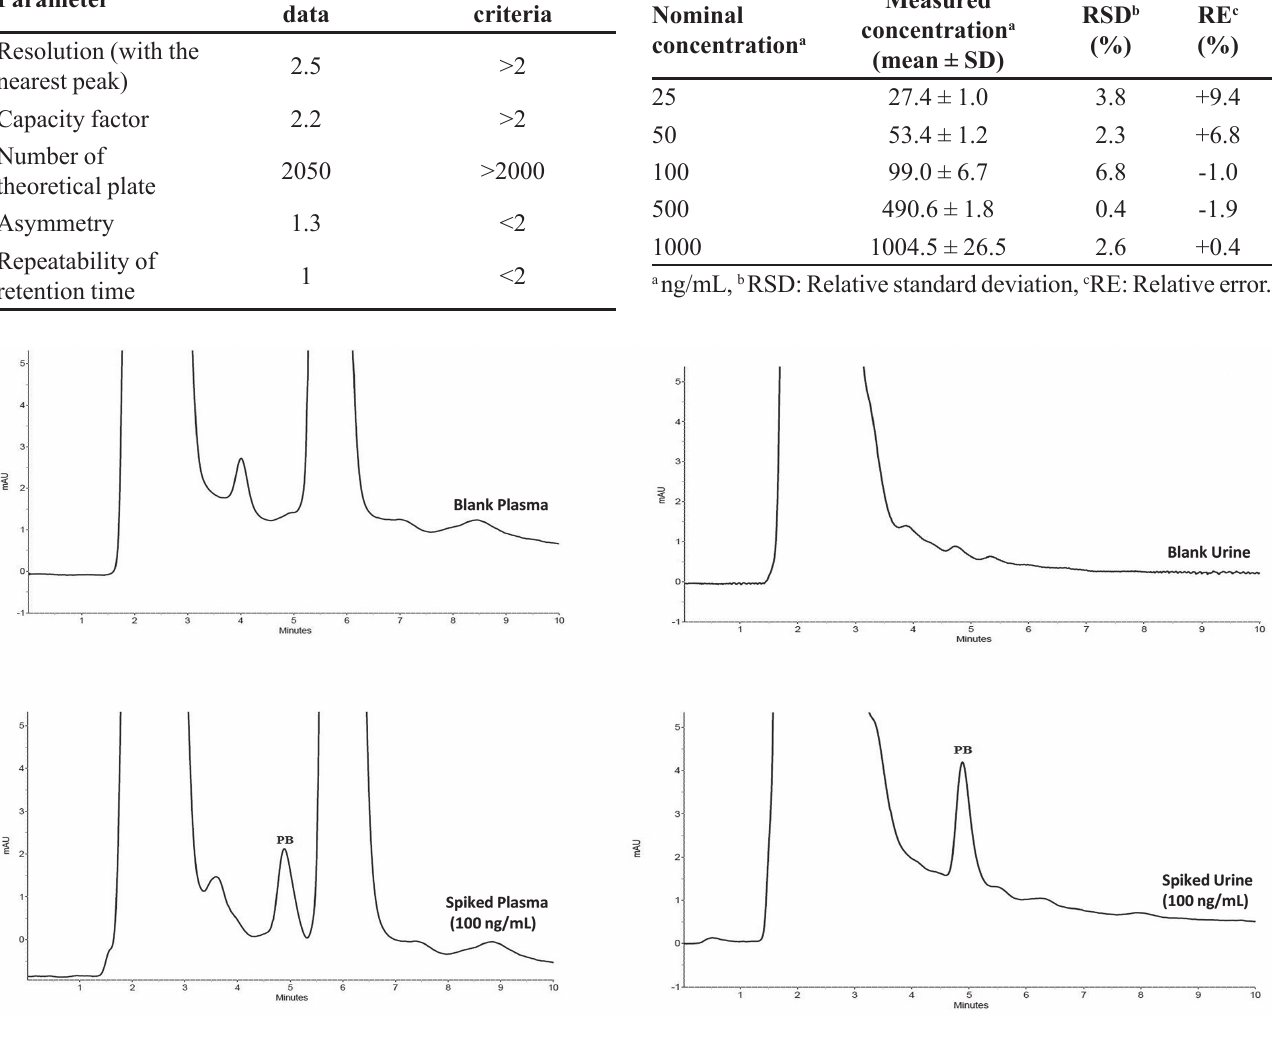
FIGURE 6 - Typical chromatograms following the EME of plasma and urine samples (peak PB is